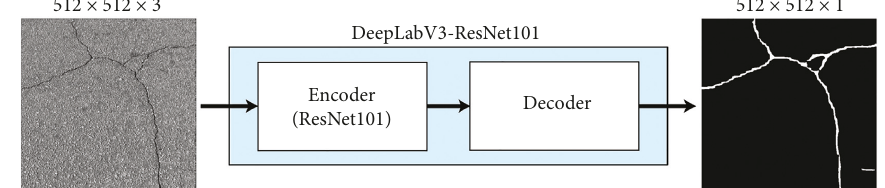
Figure 1: A high-level illustration of DeepCrackV3-ResNet101 used in this work. For more details of DeepLabV3-ResNet101, please refer to the original paper